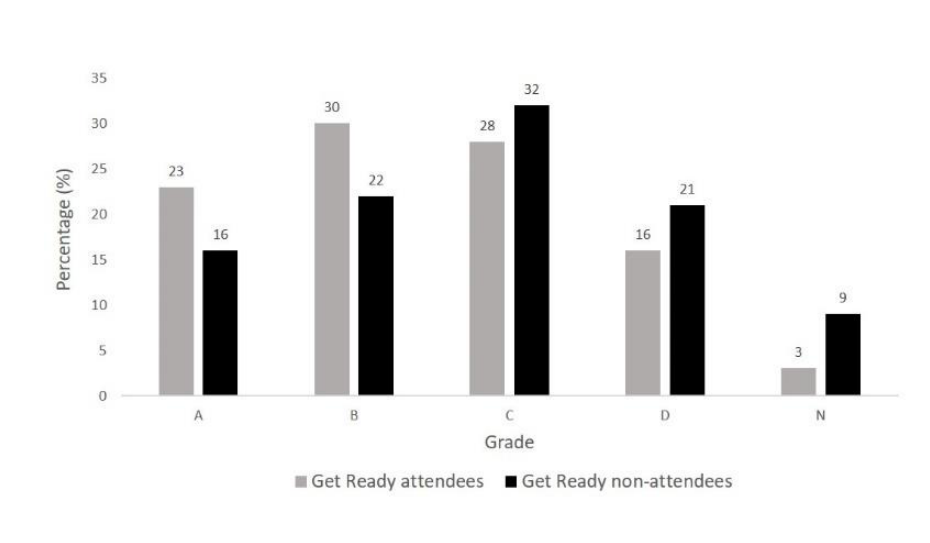
Overall performance of Get Ready attendees vs. non-attendees (2014-17)